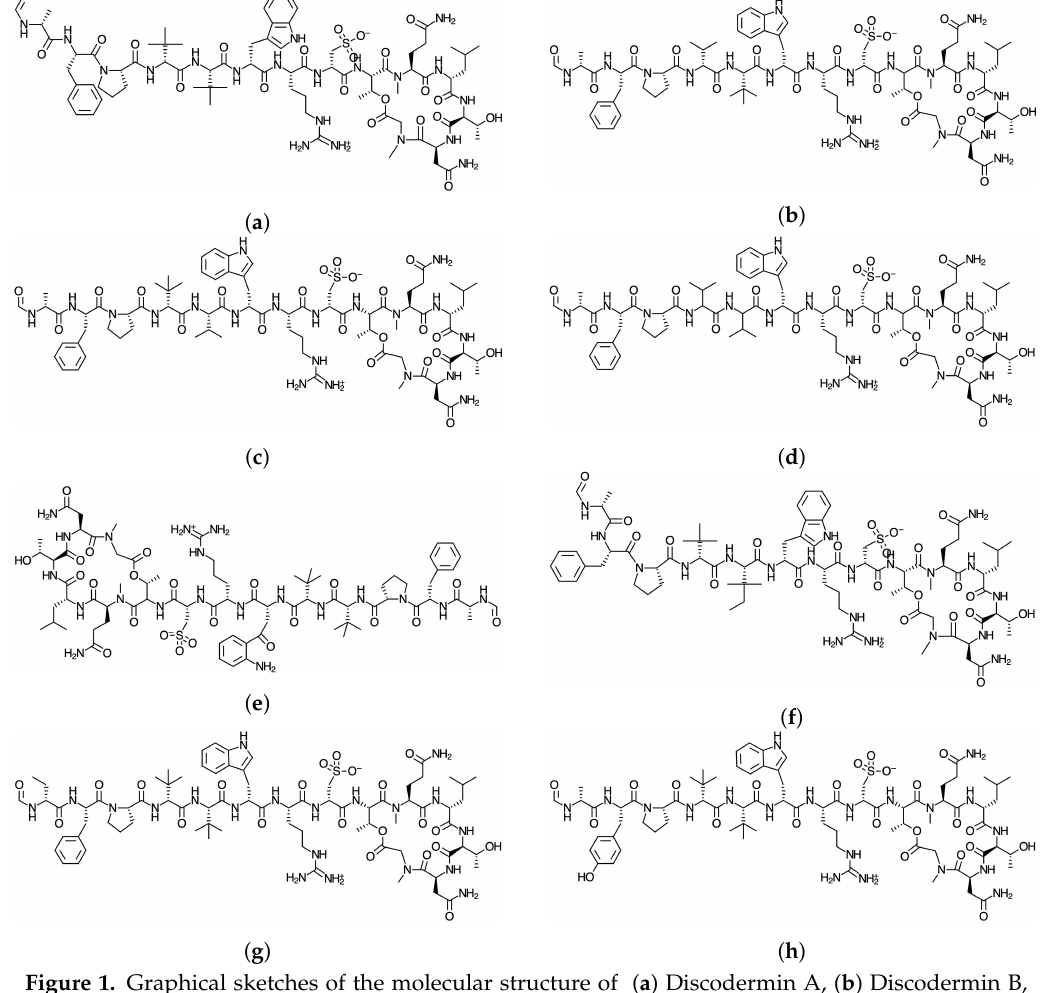
Figure 1. Graphical sketches of the molecular structure of ( a ) Discodermin A, ( b ) Discodermin B, ( c ) Discodermin C, ( d ) Discodermin D, ( e ) Discodermin E, ( f ) Discodermin F, ( g ) Discodermin G, and ( h ) Discodermin